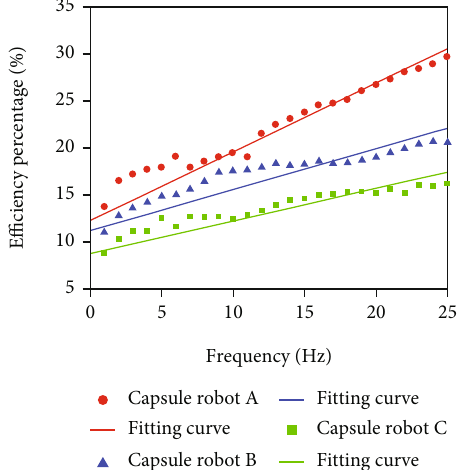
Figure 13: The actual working e ffi ciency of three capsule robots at di ff erent frequencies.